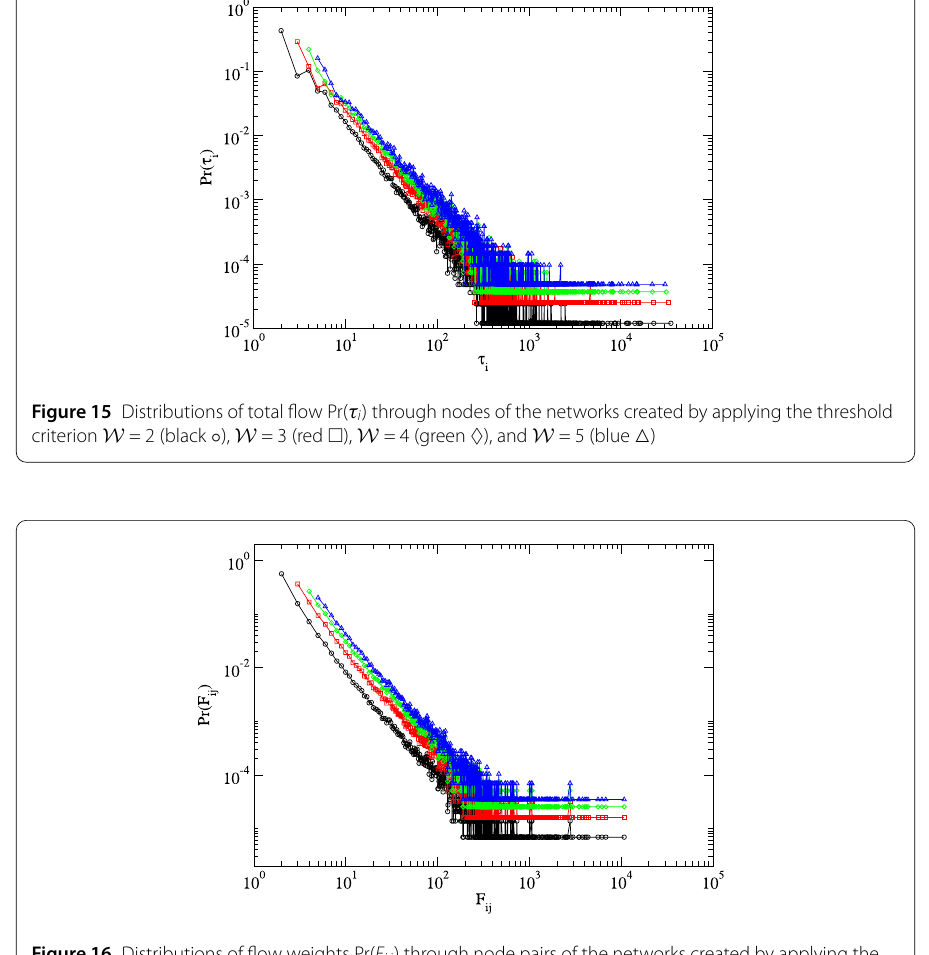
and Pr ( τ ( s ) ) are virtually identical given the condition of the Monte Carlo to fix τ i per node i to satisfy the labor supply assumption. g The other distributions, however, differ between their observed and random versions. The fixed flow condition has a tendency to spread flows evenly over nodes which leads simultaneously to nodes that tend to have larger de- gree in simulation than in reality and links that tend to have more homogenized flows than in the real system. The effect on weights is strong enough that it is patently easy to see in the distributions. However, it is slightly harder to see the effect on k i , but an elo- quent illustration of the effect can be found in the scatter plot Fig. 20. In this plot, we see that virtually none of the degrees generated as a result of the labor flow assumption is smaller than k i . The results systematically generated larger degree. If labor supply was properly descriptive of the real network, the cloud of generated degrees should lie evenly along the diagonal. It is of note that only approximately 0.12% of the nodes have a degree in the simulated networks that is less than the actual degree of the node; most simulated degrees are equal or larger than observed degrees. This makes clear the disparity between the networks that emerge from the labor supply assumption versus the observed